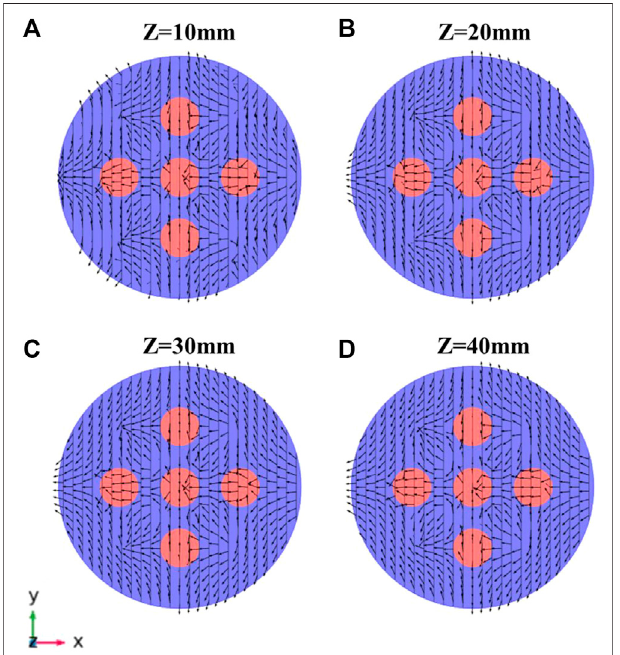
FIGURE13| Orientation ofmaximumhorizontalprincipalstress S Hmax in X-Y planes. Arrows denote directions of S Hmax and red circles denote gravels. Results are for X-Y planes of (A) Z (cid:2) 10 mm, (B) 20 mm, (C) 30 mm, and (D) 40 mm.